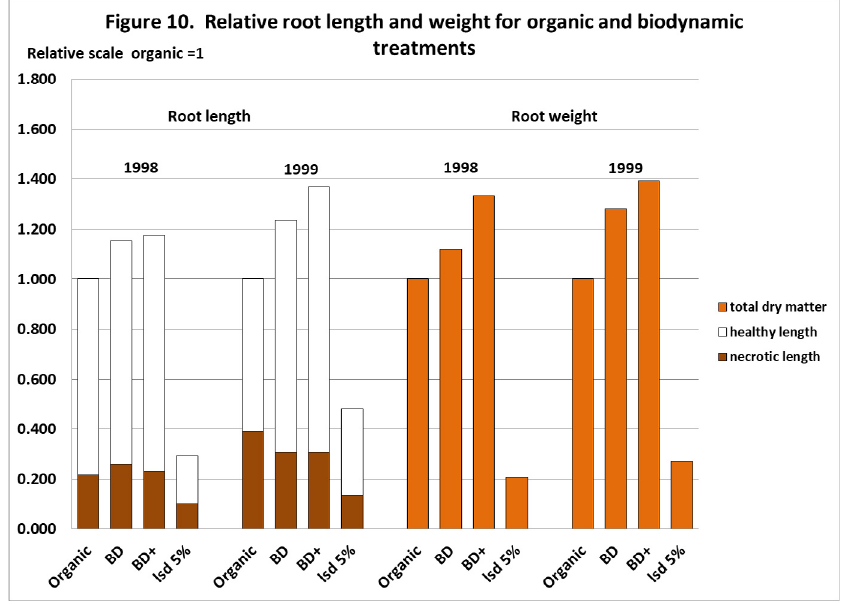
Figure 10: Relative root length and weight for organic and biodynamic treatments